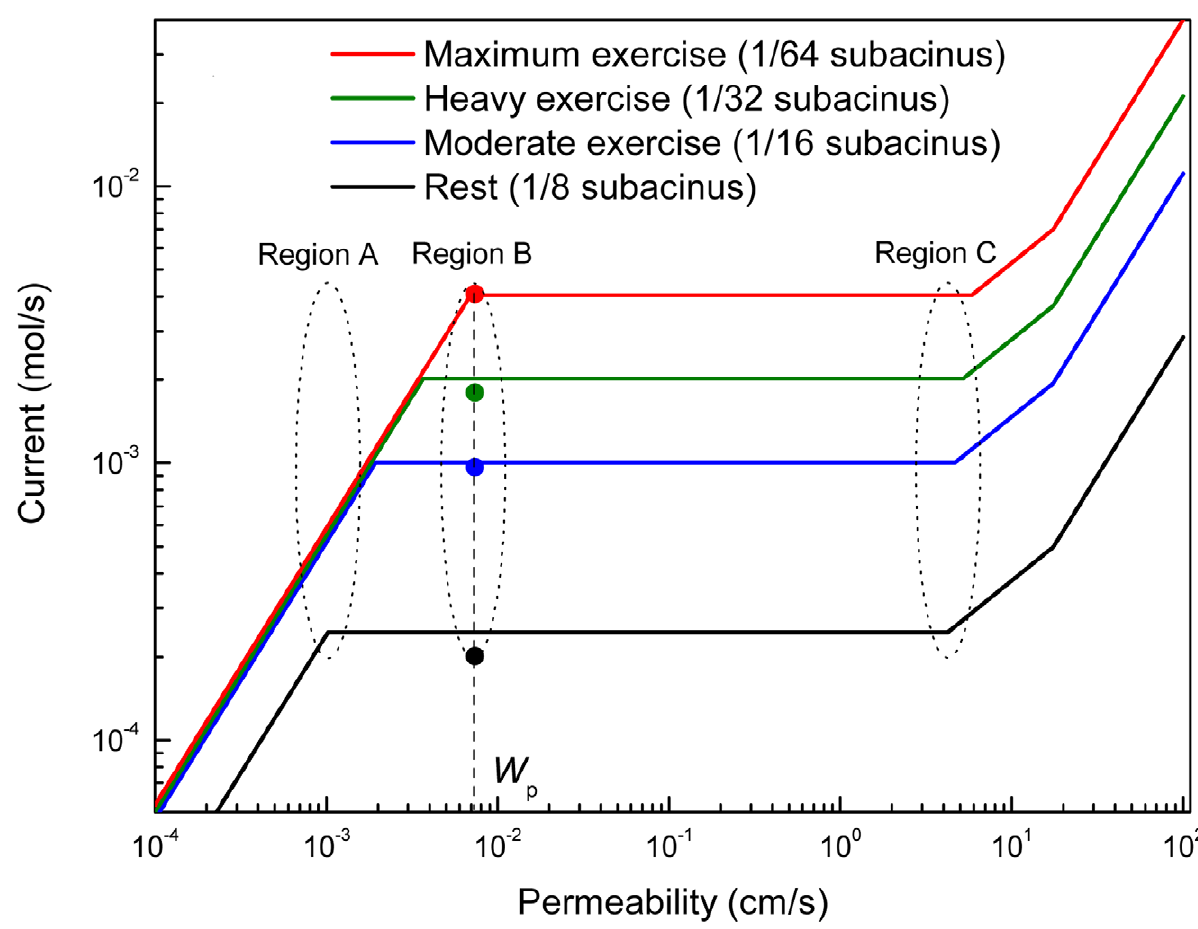
Figure 4. Computed oxygen currents for the lung. Currents for the whole lung are computed for variable W and compared with experimental values (dots). Regions A, B, and C show the effects of operating the lung at the physiological value of W , W p , and far way away from W p (see text). At moderate, heavy, and maximum exercise, the O 2 partial pressure difference across the membrane remains essentially constant, p a { p b ~ 7 : 9, 9 : 6 and 8 : 7 Torr (Table 2). Accordingly, the respective currents are computed replacing the three p p a { p b ~ 8 : 7 Torr , which makes the currents in the no-screening regime, W b a ( p a { p b ) N g S g , coincide. The currents are computed from Eqs. 4 and 5. Permeability, W , is treated as a variable. The transport parameters in the equations are listed in Table 1, and the structural parameters at different levels of exercise are listed in Table 2 (column 2, 3, 4, and 5). The fractal dimension, D f , is taken to be 3.